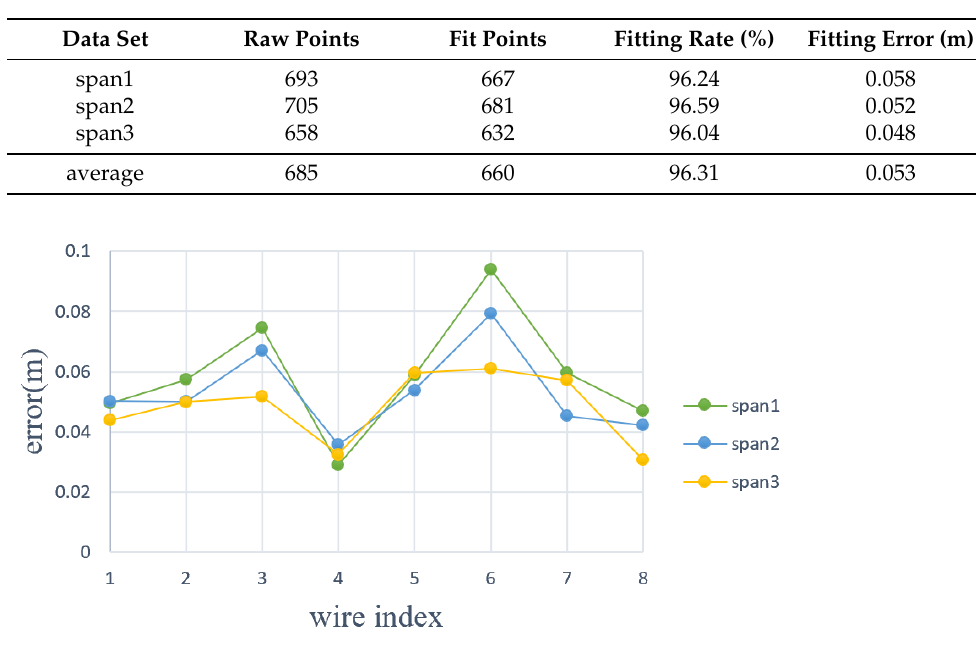
Table 8. Fitting rate and fitting error of the railway overhead wires at each span.